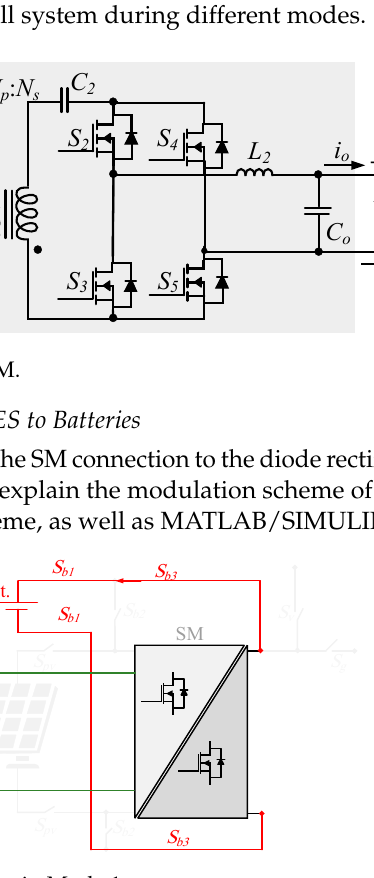
Figure 9. SM connection in Mode 1.